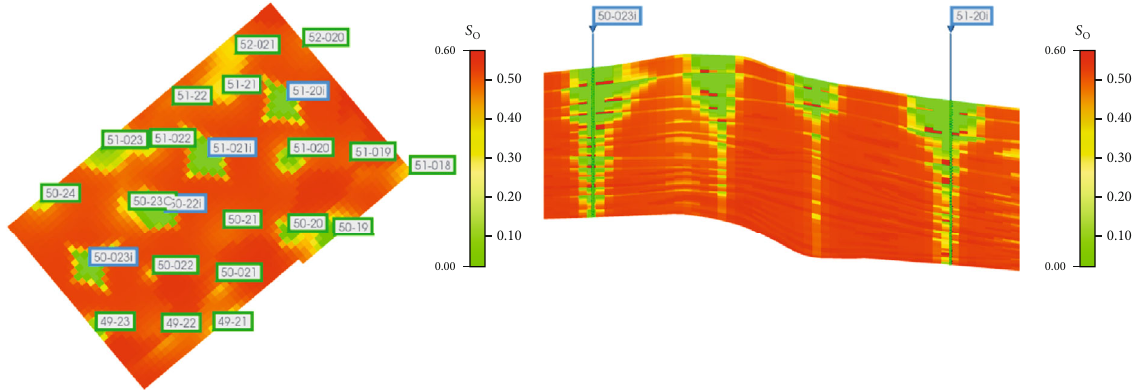
Figure 20: Prediction of ISC process oil saturation distribution for the D block sector model (layer 10 and reservoir cross-section,